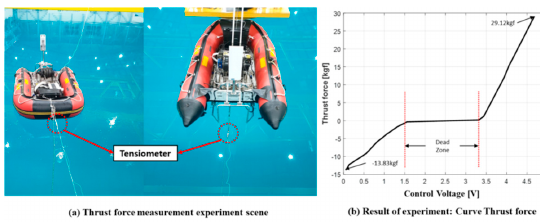
Figure 4. Thrust force measurement of the USV.